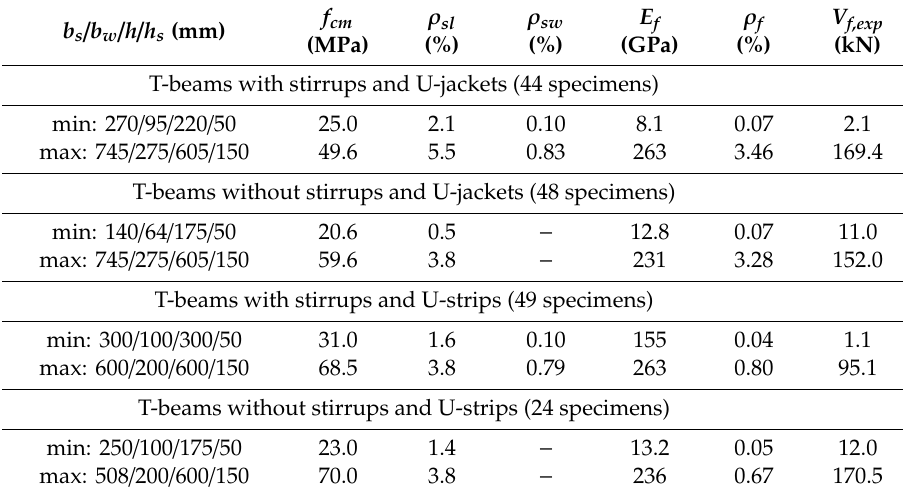
Table 3. Summary of the experimental database characteristics.